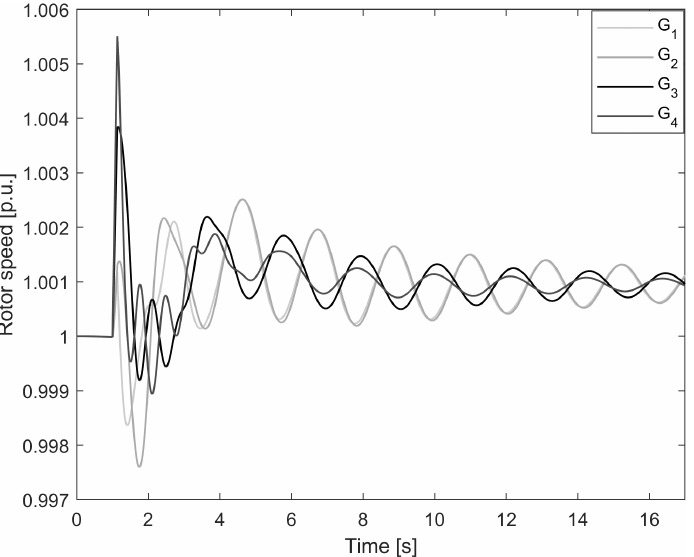
Figure 5. Time domain simulation considering a three-phase fault on the tie